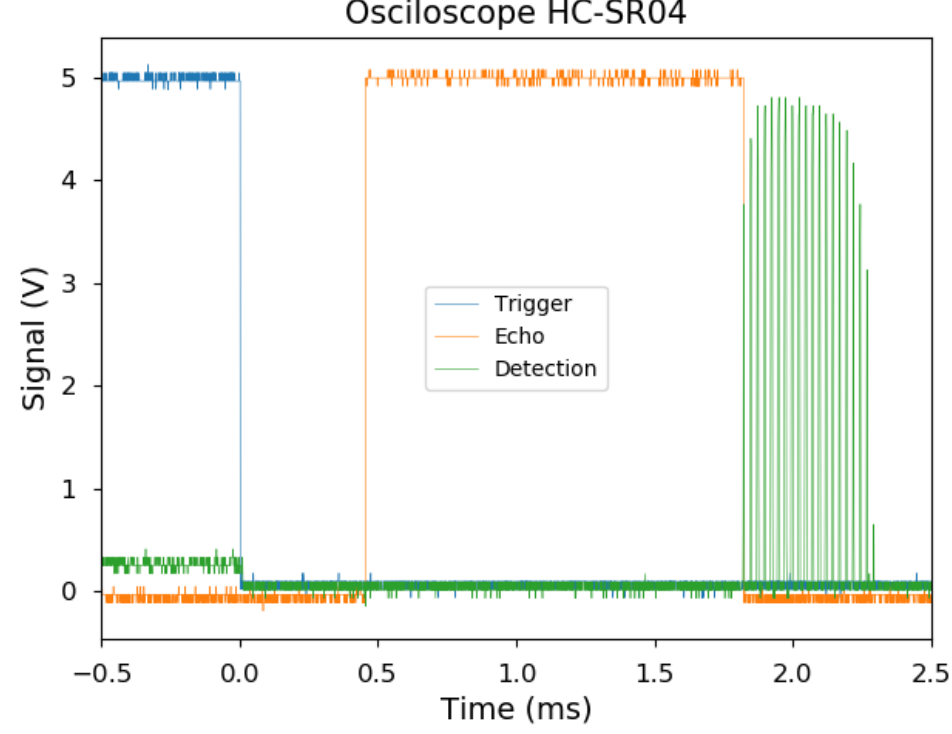
Figure 4. Signal obtained from HC-SR04 “Trig” pin (blue line), “Echo” pin (orange) and detection (green) of a flat object at 30